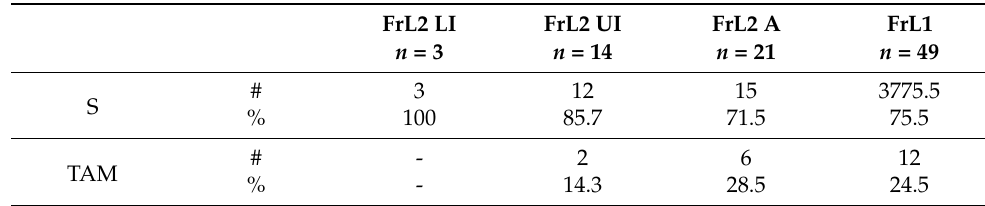
Table 3. Distribution of spatial (S) and temporal, aspectual, and modal (TAM) values of aller + V among FrL1 and